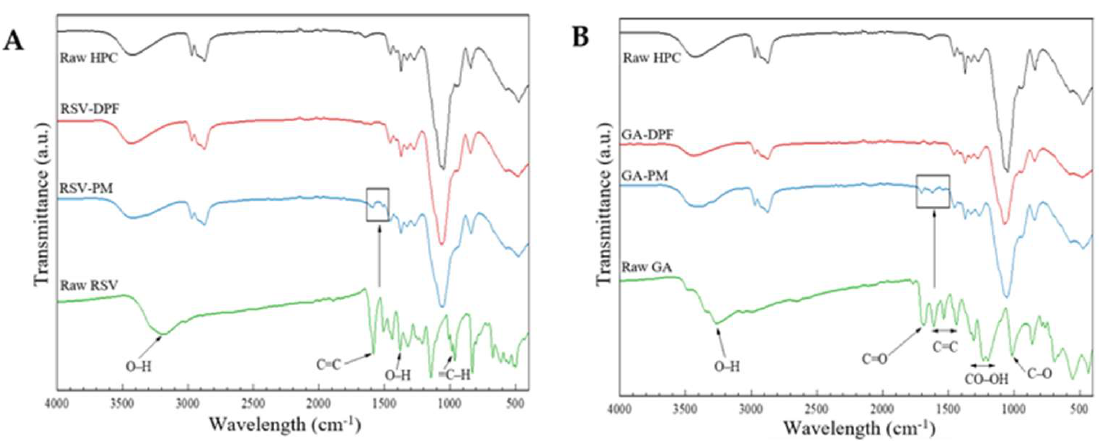
Figure 7. ATR-FTIR spectra for the ( A ) RSV–DPF and ( B ) GA–DPF; PM: physical mixture.